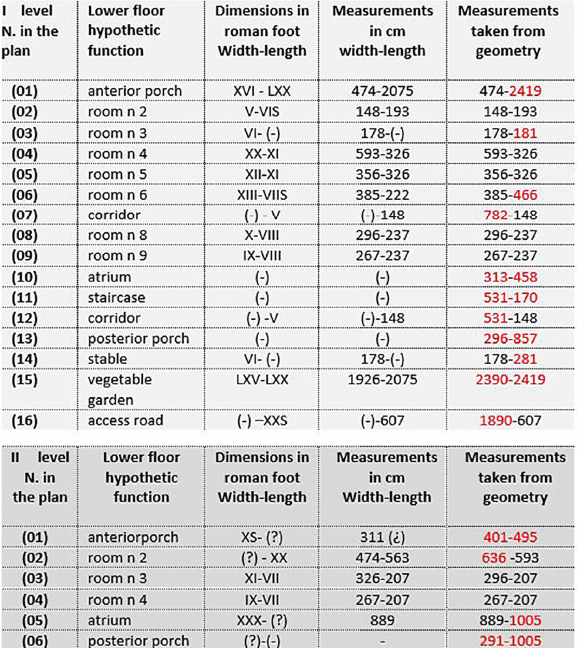
Table 1. Edificium custodiae . Numerical comparison between the data quoted in figures (Roman feet) transposed in cm and measured in the marble reduction scale. The distribution of spaces refers to the study by Rodriquez Almeida, 2002, fig. 13, chap. IV.